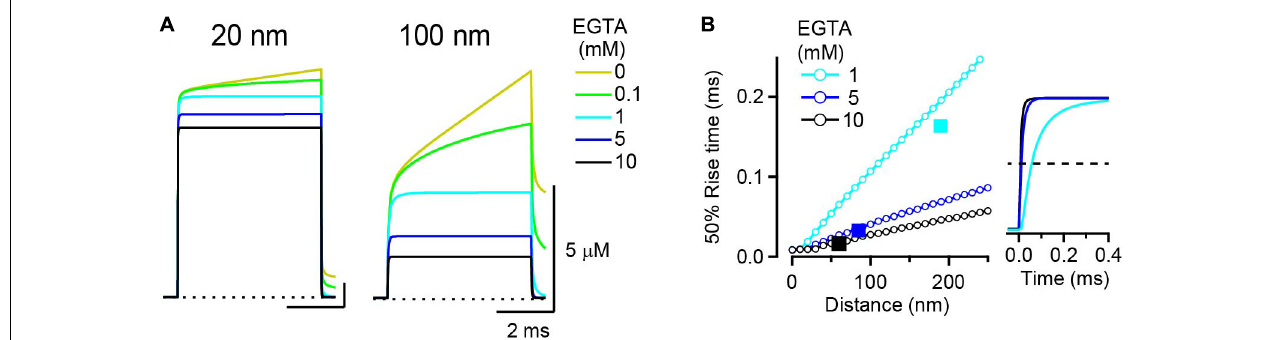
FIGURE 2 | Rise kinetics of [Ca 2 + ] i transients. (A) [Ca 2 + ] i transient at 20 nm (left) and 100 nm (right) from a VGCC in the presence of various concentrations of EGTA. Single VGCC current was 0.3 pA in amplitude and 5 ms in duration. (B) Relationship between [Ca 2 + ] i transient kinetics and the distance; 50% rise time of [Ca 2 + ] transients from RDS in the presence of 1, 5, and 10 mM EGTA was plotted against voxel distance from the VGCC. For comparison, the time constant [ τ (ms)] from LBA plotted against the space constant [ λ (nm)] for each EGTA concentration is denoted as a filled square. Traces in the right panel represent [Ca 2 + ] i transients (normalized with amplitude) at the voxel closest to the distance λ (190 nm for 1 mM; 80 nm for 5 mM; 60 nm for 10 mM EGTA). Horizontal dashed line denotes 50% rise of the transients.